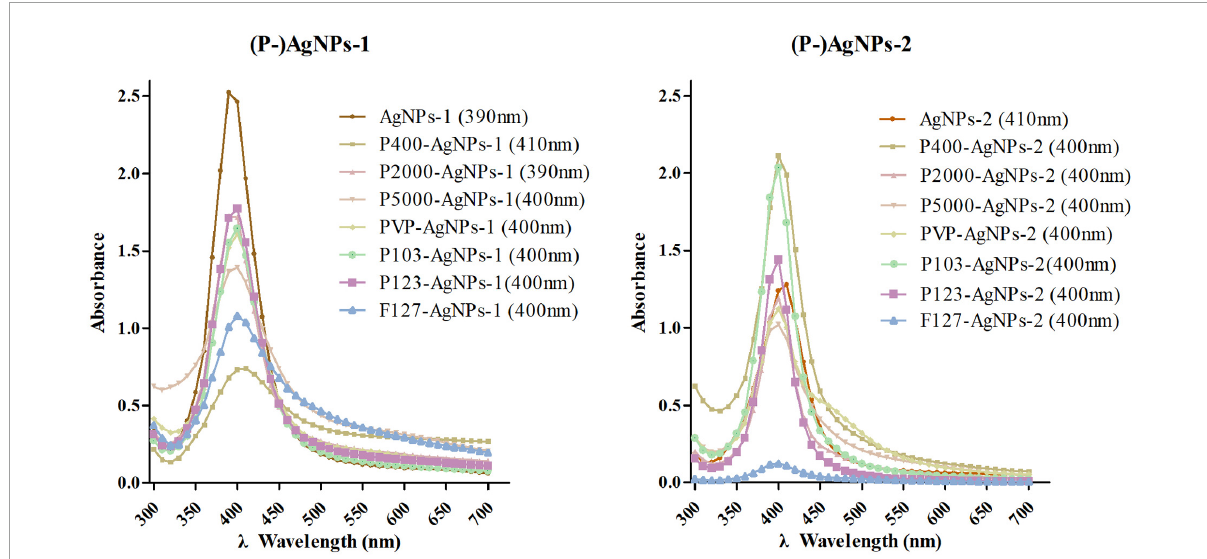
FIGURE1 The UV-Vis absorption spectroscopy detection of AgNPs-1/2 and P-AgNPs-1/2. In parentheses is the peak value of the samples.